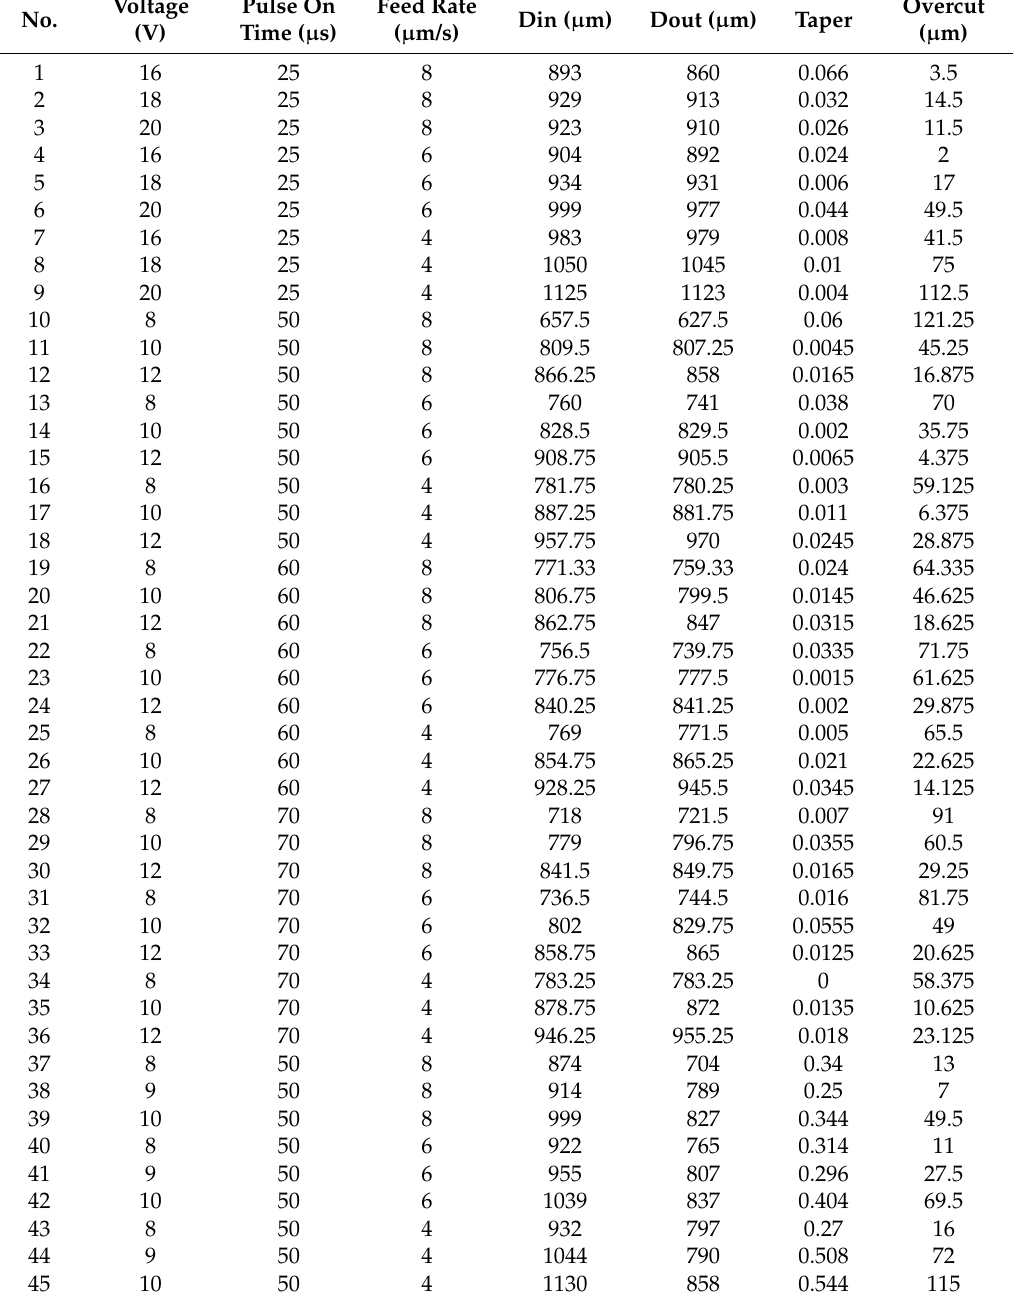
Table A1. Data used for training and testing the neural network